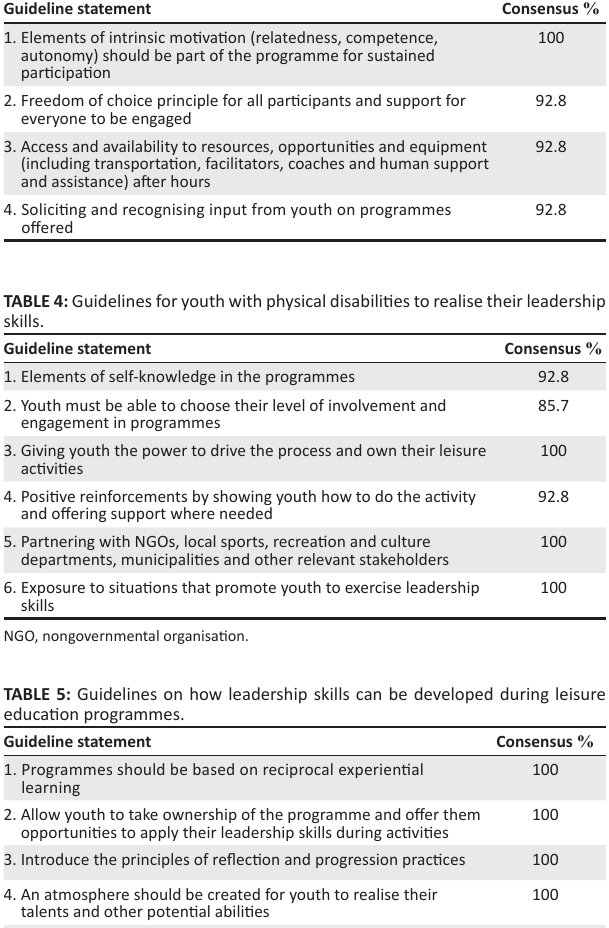
TABLE 1: Demographic information of the participants in round one. Participants’ location